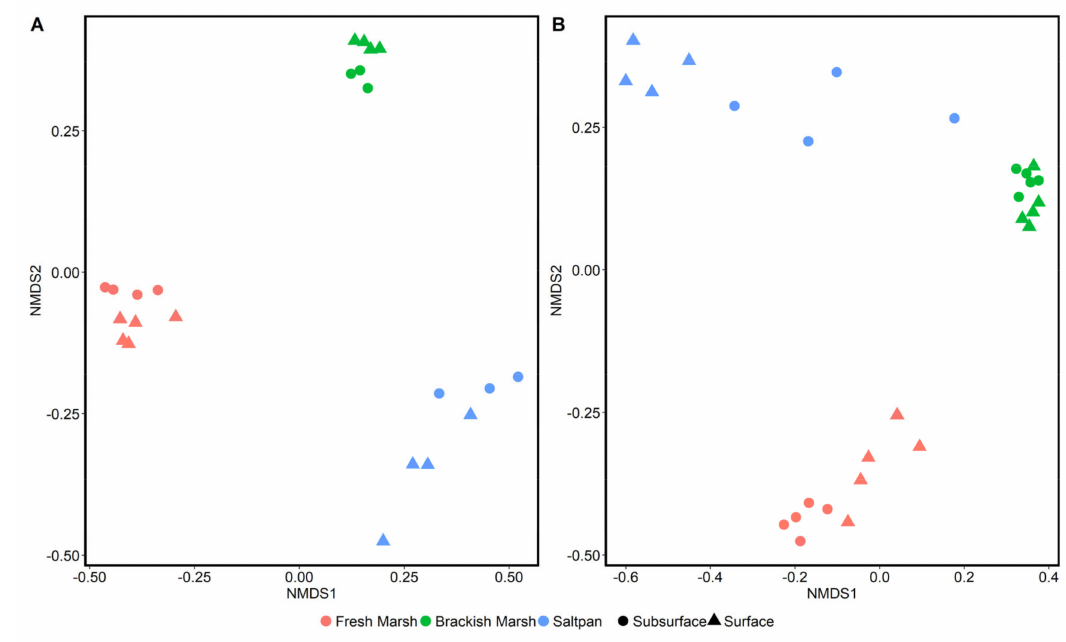
Figure 4. NMDS ordination of bacterial ( A ) and archaeal ( B ) communities in wetland sediment, collected from Grand Bay National Estuarine Research Reserve in southeast Mississippi, USA. Wetland salinity class is represented by color and soil level represented by shape. Ordinations are based on Bray–Curtis dissimilarity matrices derived from 16S rRNA gene sequence